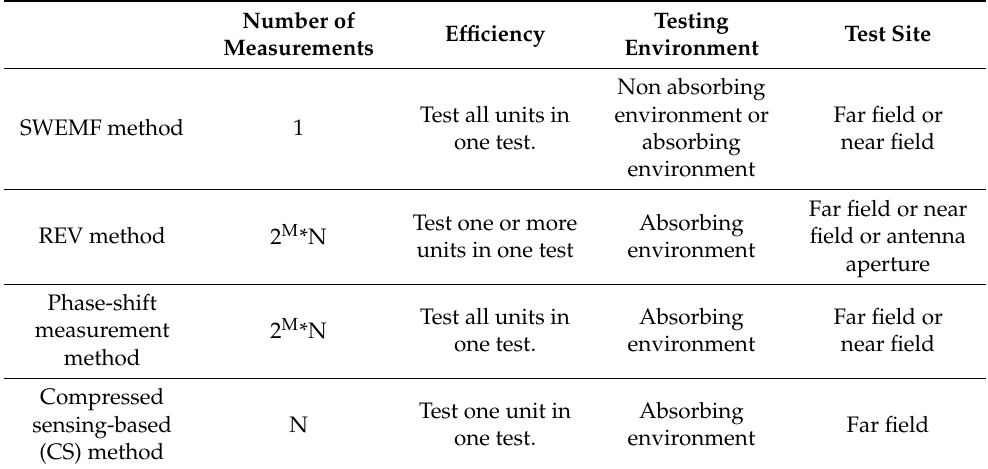
Table 3. Comparison of different